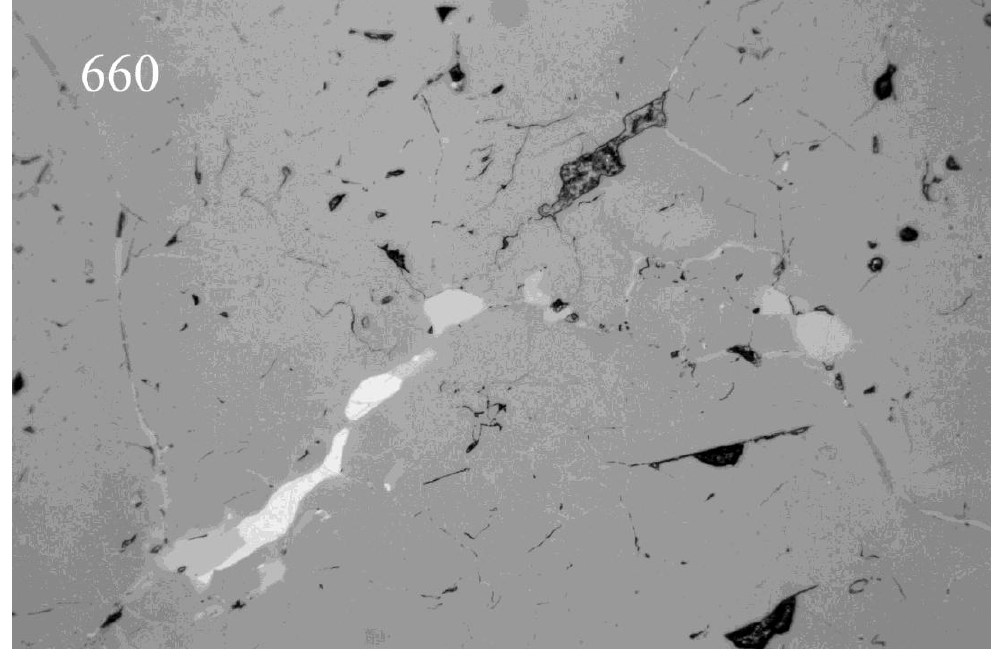
Figure 4. Vermicular aggregates of Mg-ilmenite and rutile, and kaolinite filled pores in CHR-2 massive chromitite. Parallel Nichols reflected light picture, long side = 1.0